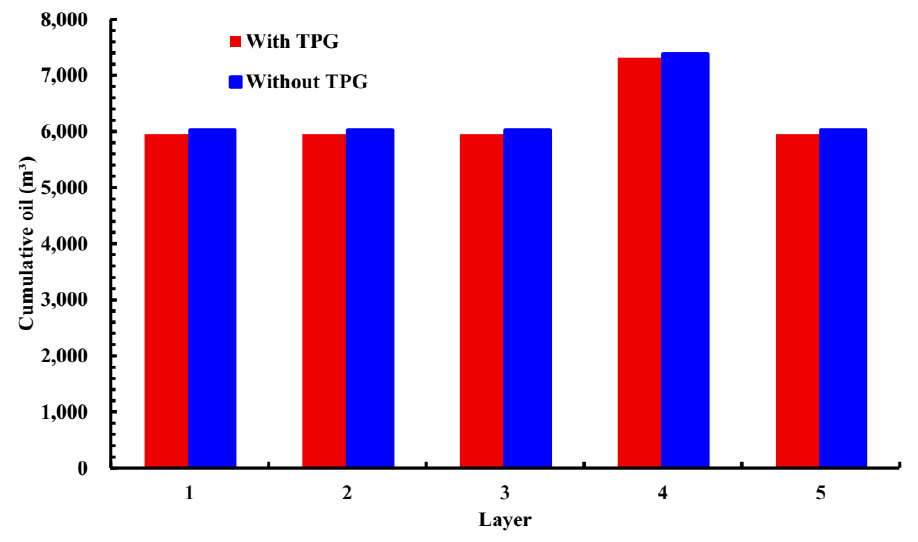
Figure 9. Calculation results on the effect of the TPG.